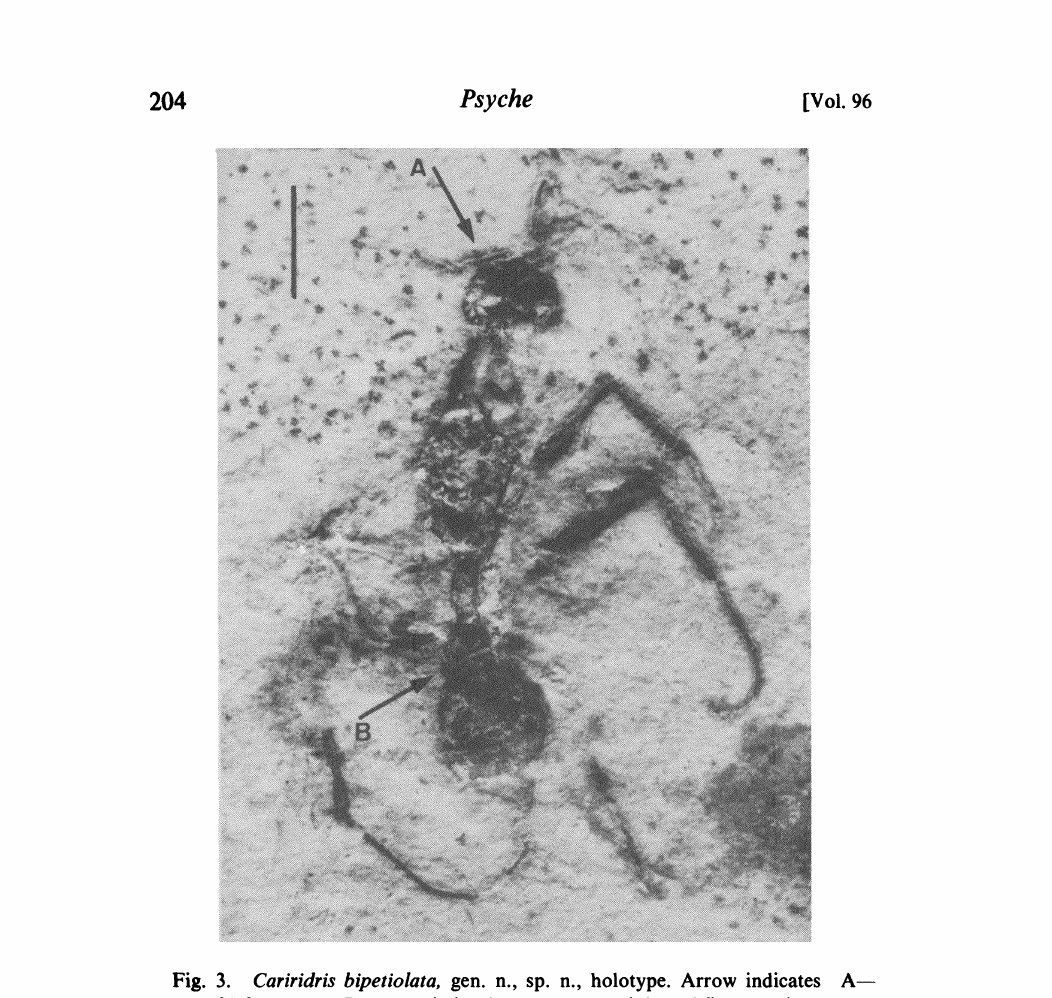
Fig. 3. Cariridris bipetiolata, gen. n., sp. n., holotype. Arrow indicates A scape of left antenna, Bmconstriction between postpetiole and first gastric segment (fourth true abdominal segment). Scale bar